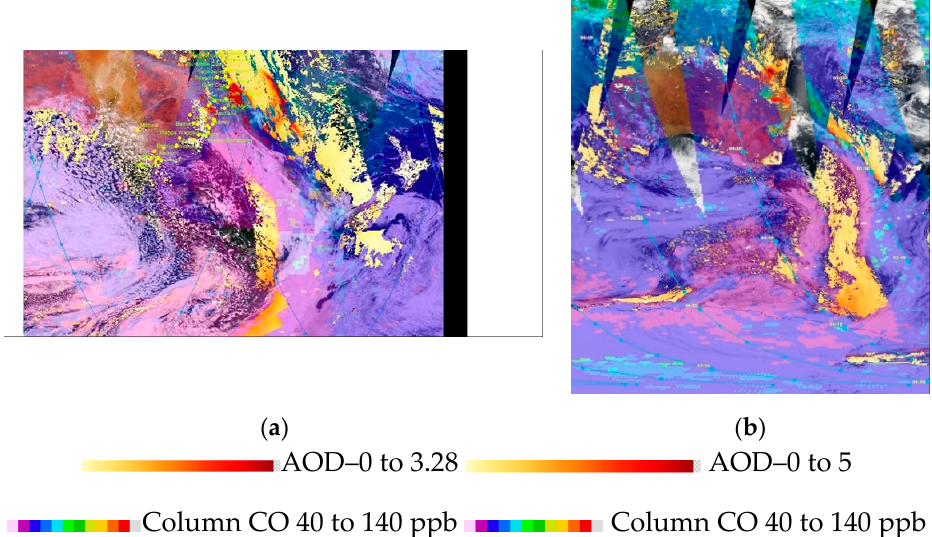
Figure 16. The AOD from Aqua / Modis and the CO column Aqua / Airs daytime concentration on 13 February 2019, as well as the location of towns and cities on the eastern seaboard of Australia ( a ); and the AOD from Terra / Modis and the CO column Aqua / Airs daytime concentration on 14 February 2019 ( b ). The pinkish and greenish colours are CO (carbon monoxide) column concentration.